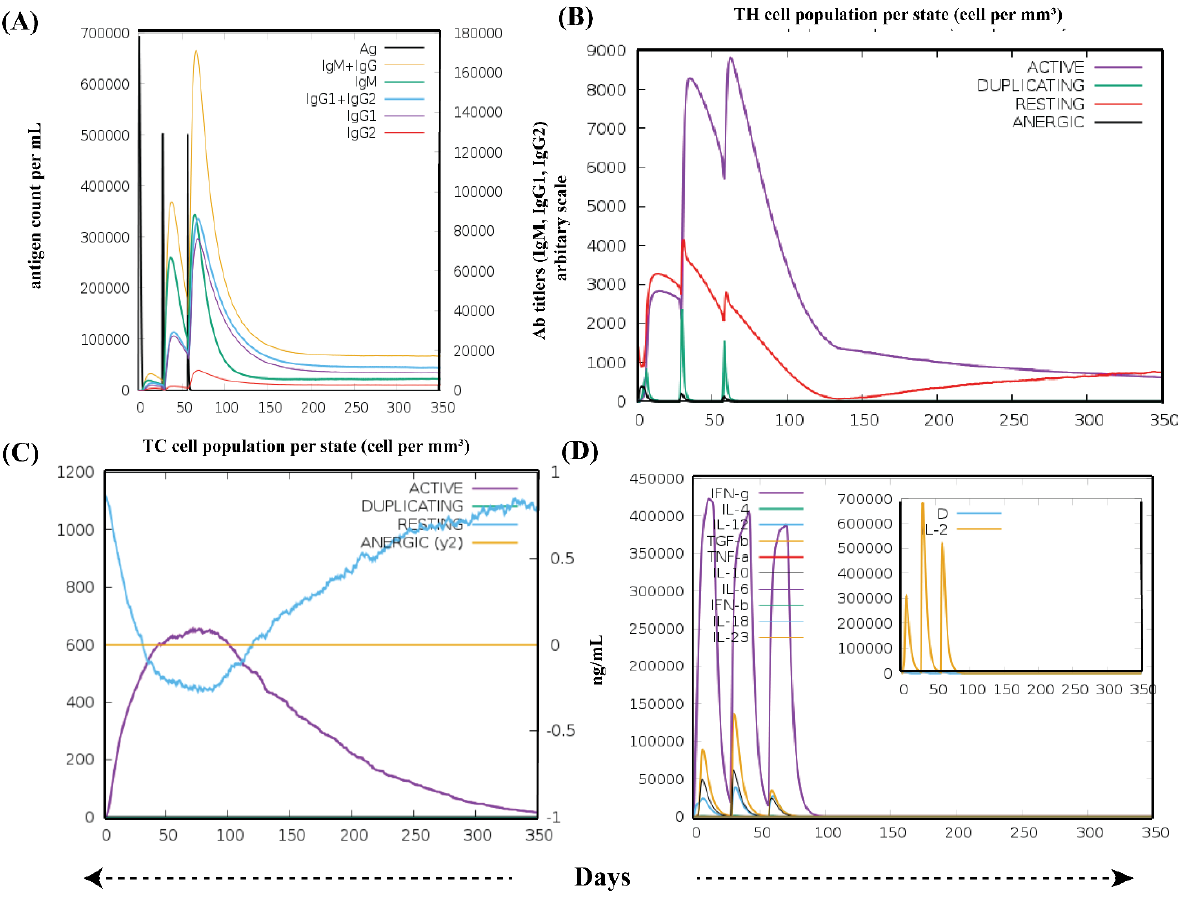
Figure 7. The immunostimulatory potential of the constructed vaccine after three injections of it. ( A ) Immunoglobulin production; ( B ) population/state of helper T-cell; ( C ) population/state of cytotoxic T-cells; ( D ) cytokines and interleukins production (smaller graph) with Simpson index. All units are stated in terms of cells per mm 3 in three consecutive immunological responses.